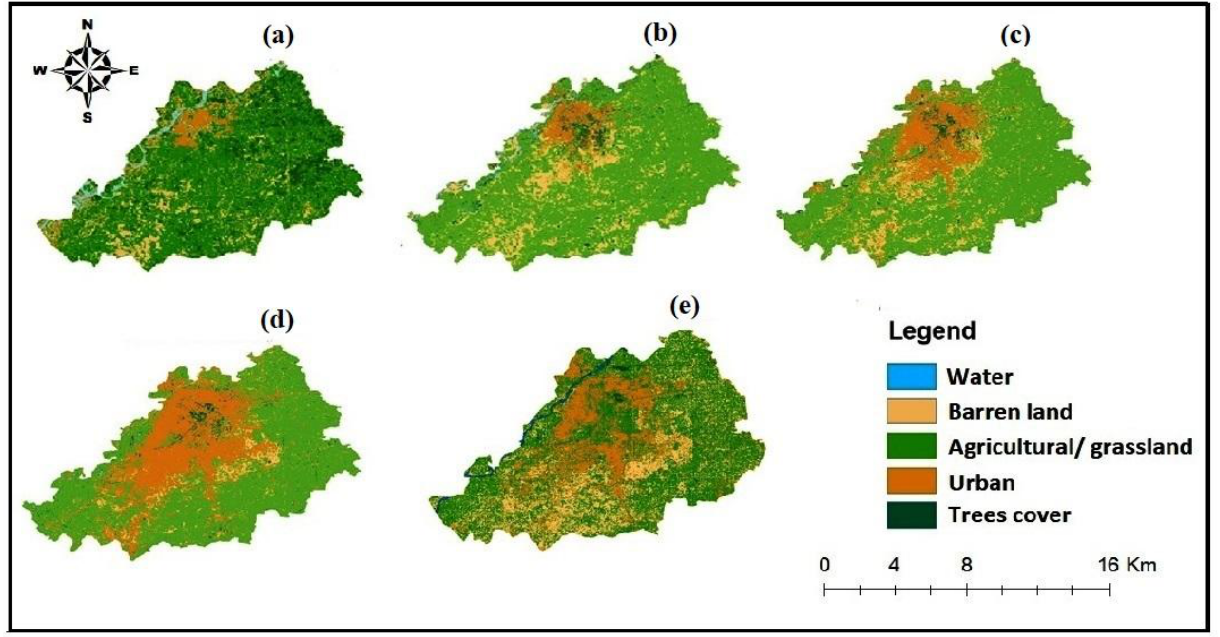
Figure 5. Spatio-temporal Analysis of Land use/land cover